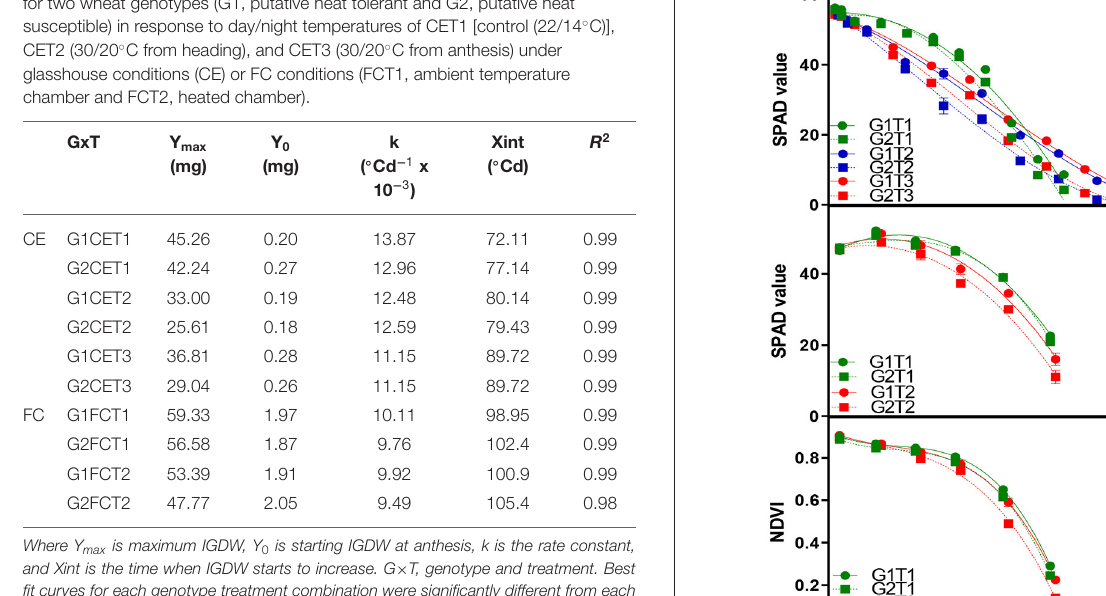
Field Chambers A significant G × T interaction ( p < 0.001) for